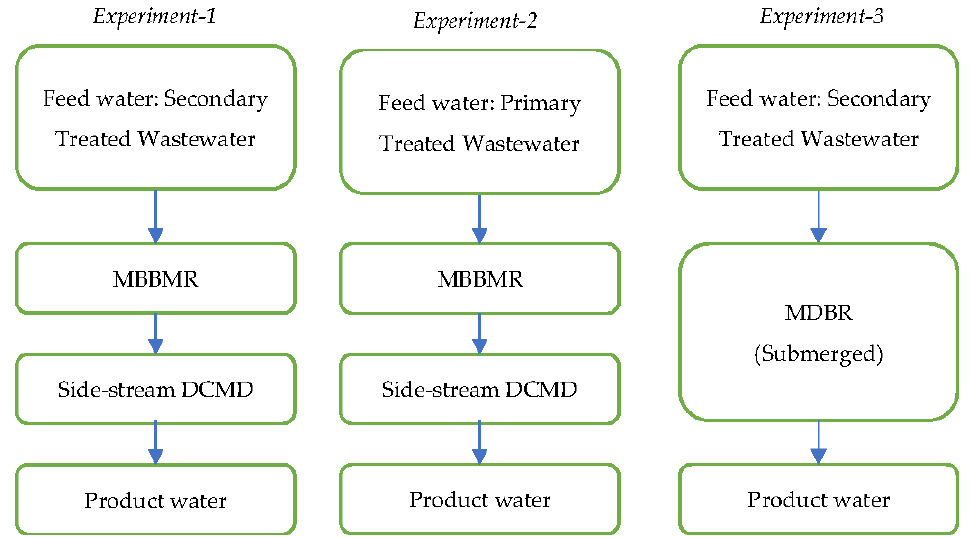
Figure 1. Configurations of the hybrid wastewater treatment and membrane processes tested, and the related experiments.